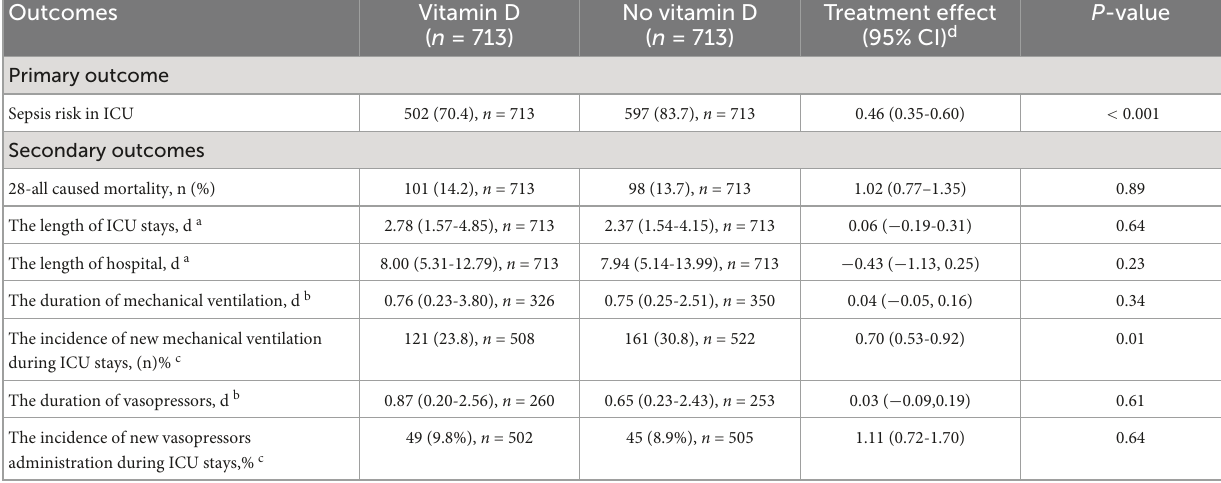
TABLE 2 Primary and secondary outcomes analysis with propensity score matching